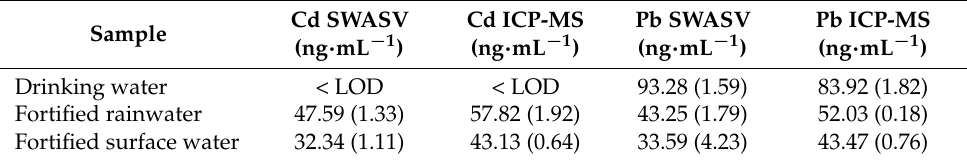
Table 2. Cd(II) and Pb(II) in real samples. 95 % confidence intervals in